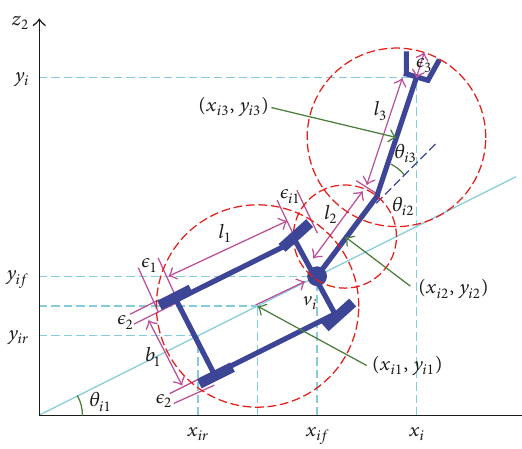
Figure 1: Schematic representation of 𝐴 𝑖 in the 𝑧 1 - 𝑧 2